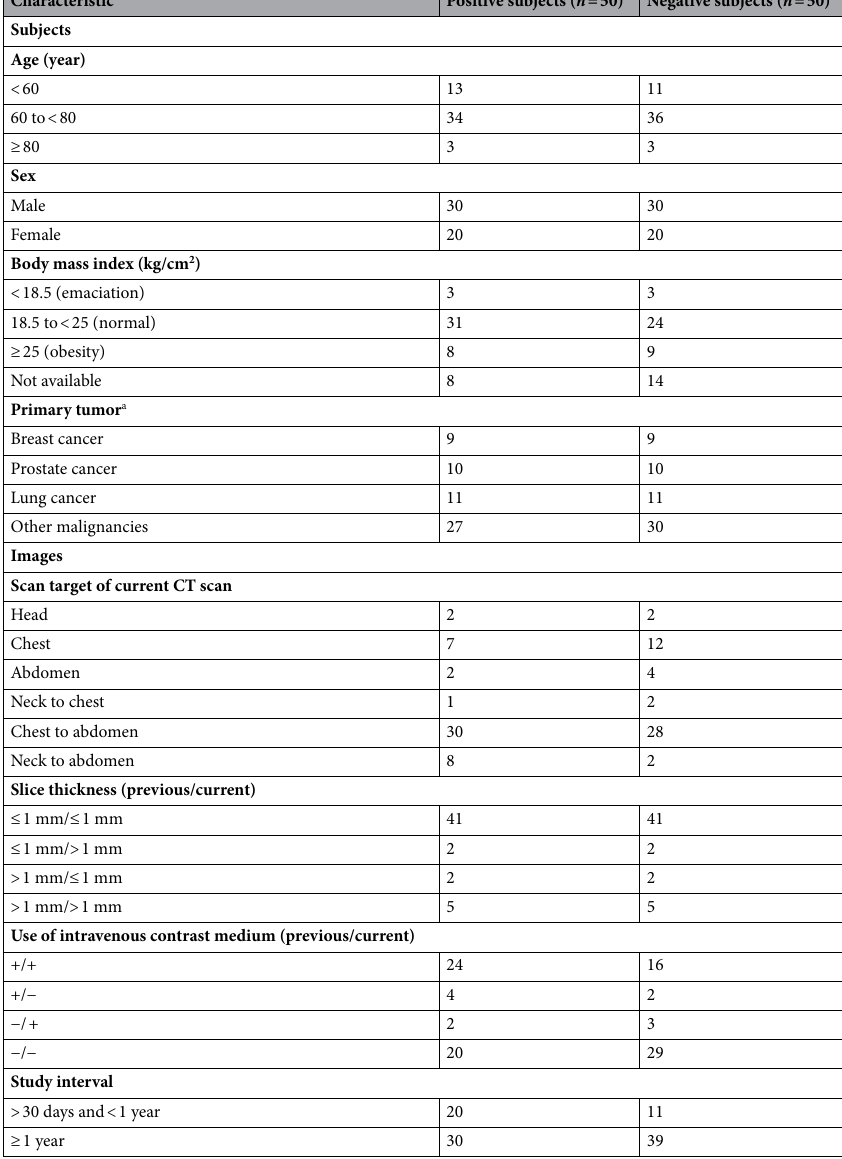
Table.1. Subject and image characteristics. CT computed tomography. a Multiple options were